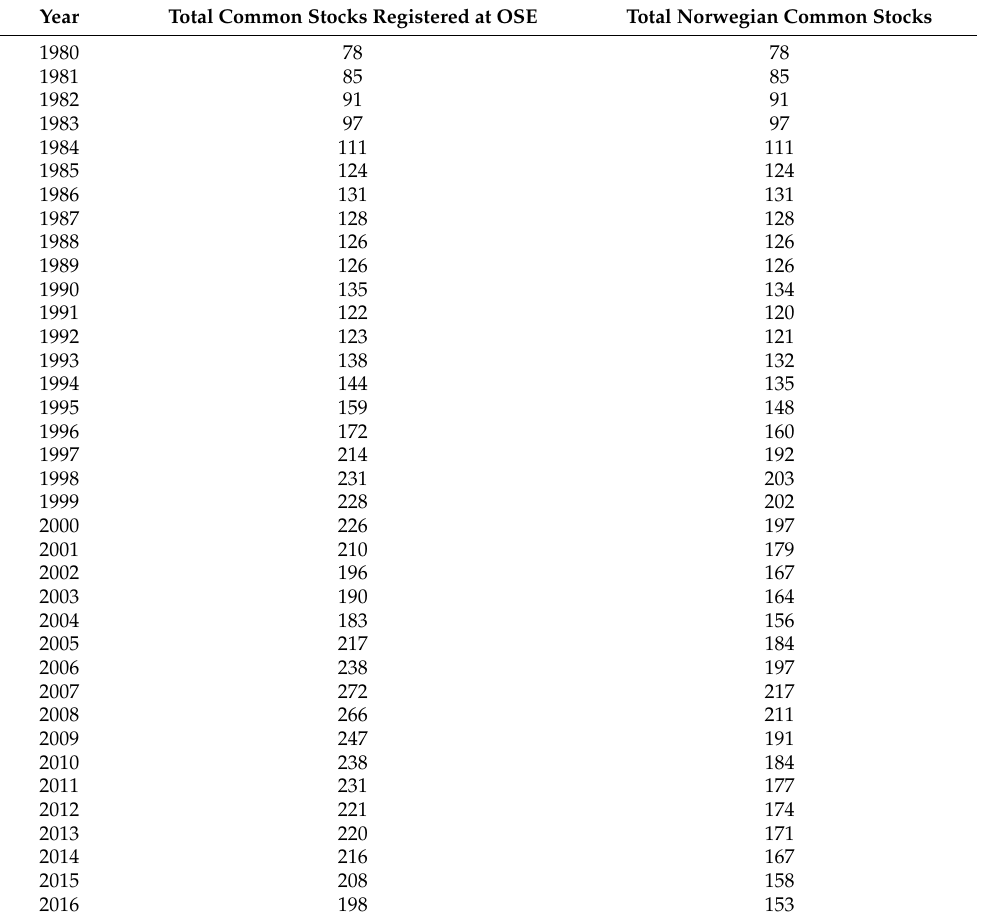
Table A1. Number of common stocks registered at OSE over the